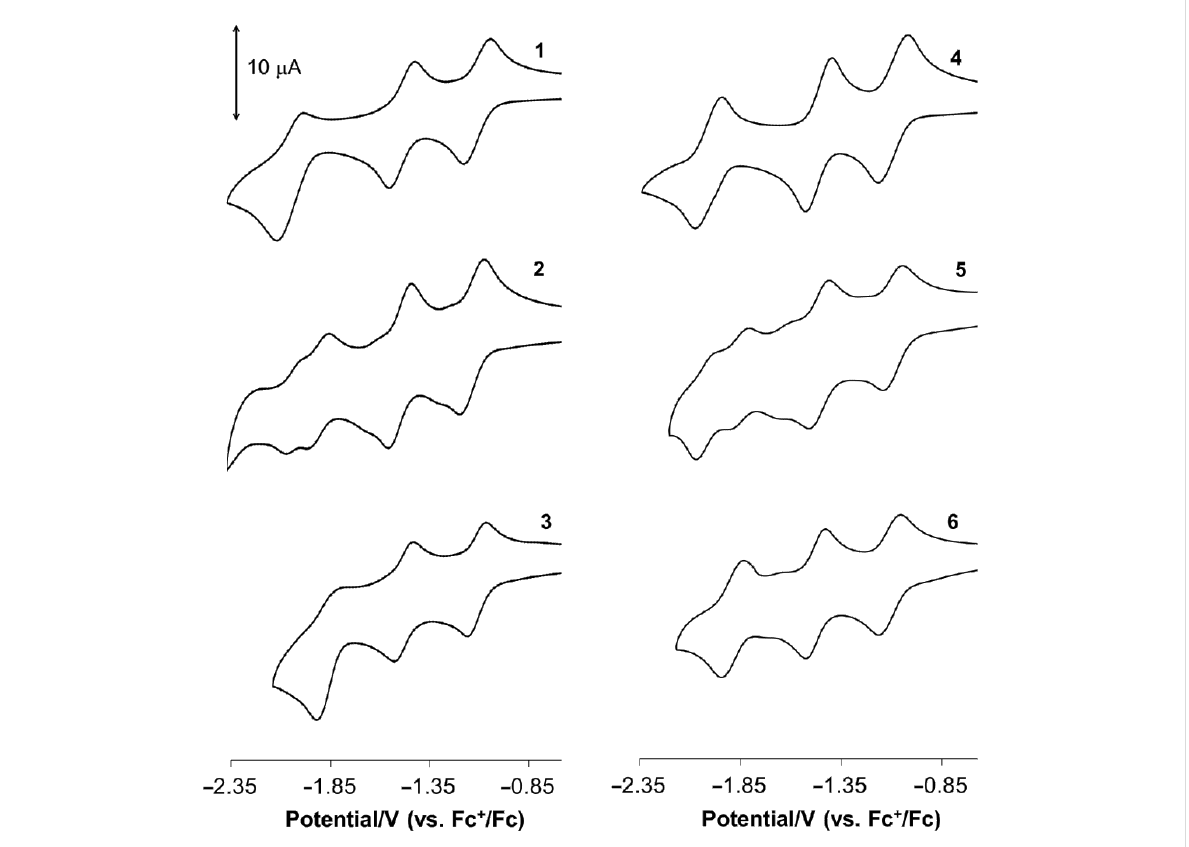
Figure 2: Cyclic voltammograms of the terephthalate bridged triads 1–3 (left) and oxalate bridged triads 4–6 (right). Data were recorded as 0.5 mM solutions in o -dichlorobenzene containing 0.2 M [ n -Bu 4 N][BF 4 ] as the supporting electrolyte, at a scan rate of 100 mV.